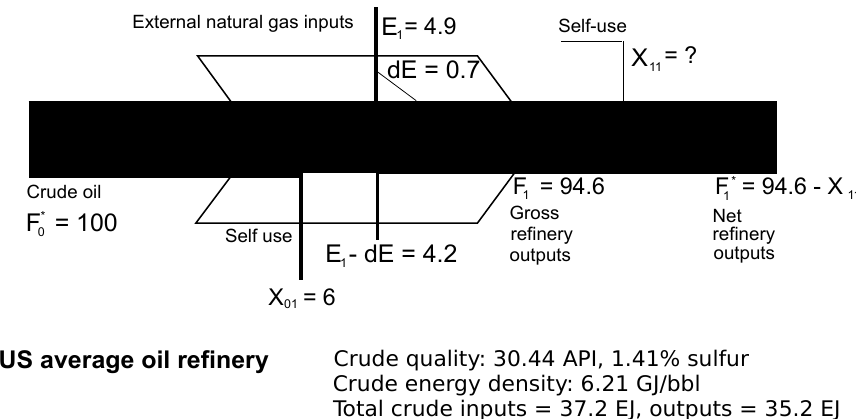
Figure 2. Observed flows in US refining sector, 2008 [45], neglecting indirect (embodied) consumption. Deviation from our simple model occurs due to the inclusion of some energy content from external natural gas inputs into the principal energy stream in the form of H (called flow dE in this figure). This flow exists in reality but is not included in our simple model of a processing stage. Flows are rounded independently and may not sum exactly to 100. Flow X is of uncertain magnitude (refined products use within refinery process 11 boundary, e.g., diesel fuel use on refinery